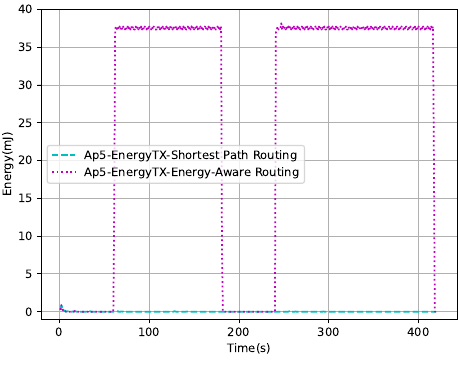
(e) Transmission energy of Access Point 5 Figure 9. Transmission